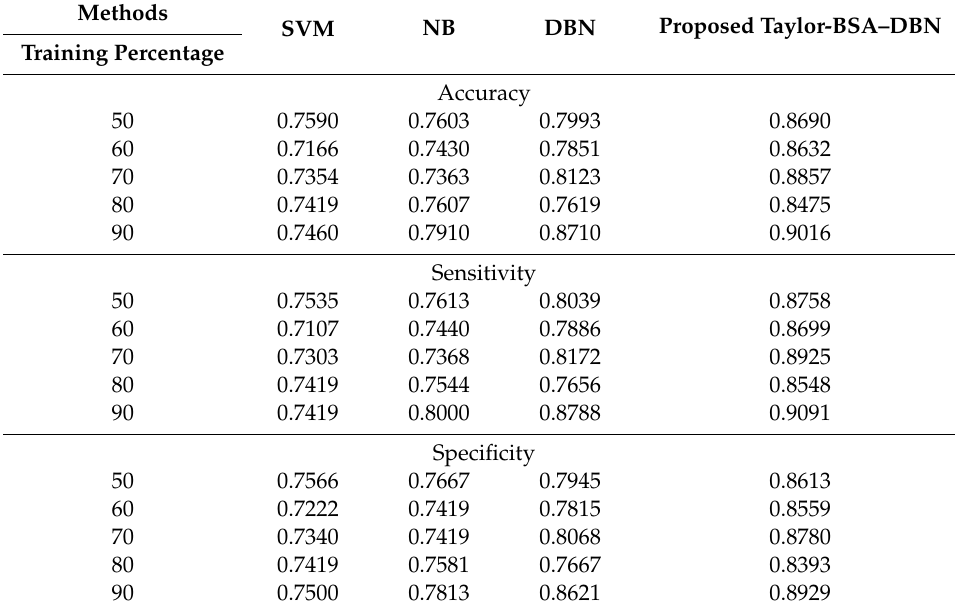
Table 5. Analysis of methods with cluster size = 9 using the Cleveland database.